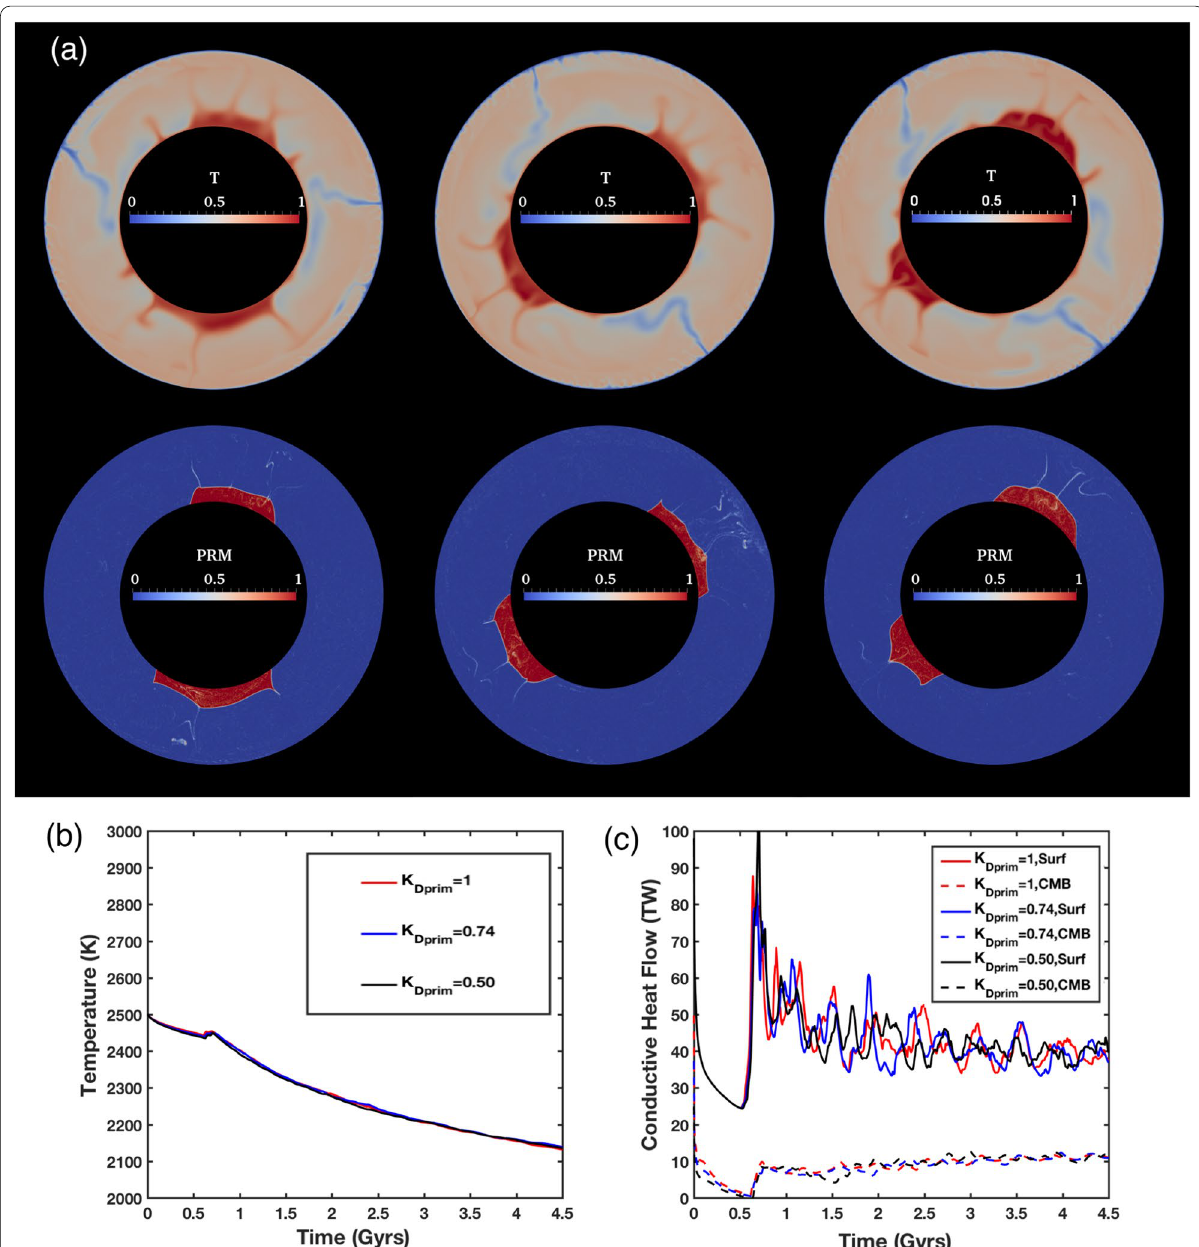
Fig. 2 H Dprim 10, a snapshots of non‑dimensional superadiabatic temperature (top) and composition (bottom) fields at t = right K Dprim varies from 1, 0.74, 0.5. b Averaged mantle temperatures as a function of time. c Surface and bottom heat flows as a function of